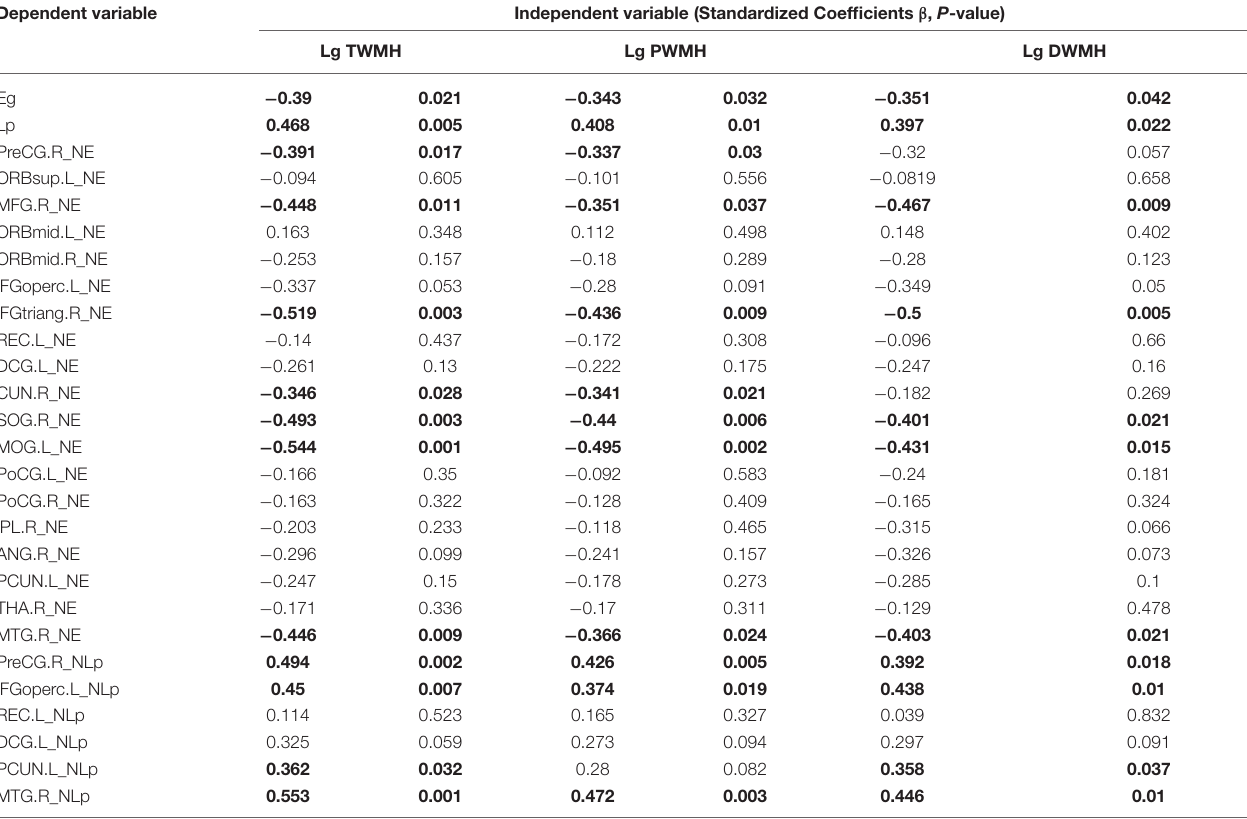
TABLE 3 | Multiple linear regression analyses of WMH volumes and cognitive function in WMH-CI. Dependent